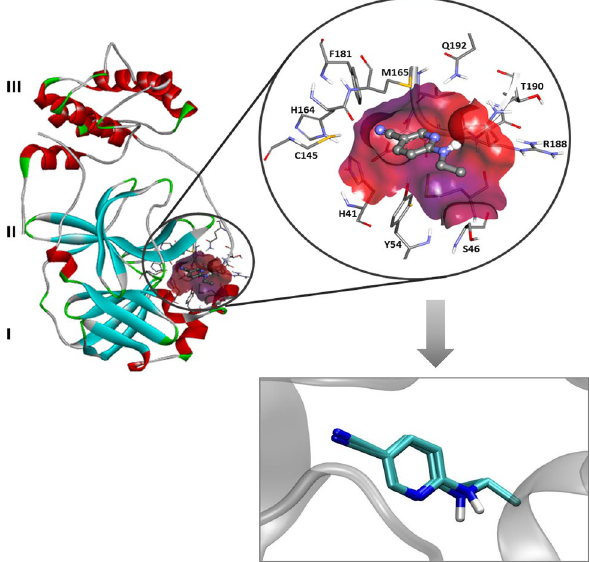
Figure 1. Crystallographic structure of the Covid-19 virus M pro enzyme with the co-crystallized ligand 6-(ethylamino)pyridine-3-carbonitrile (PDB code 5R82) (up) 30 , and re-docking result of the co-crystallized ligand through AutoDock Vina 31 as implemented in the MolAr software (down) 32 . Image generated in the Discovery Studio Software 4.5 https:// disco ver. 3ds. com/ disco very- studio- visua lizer- downl